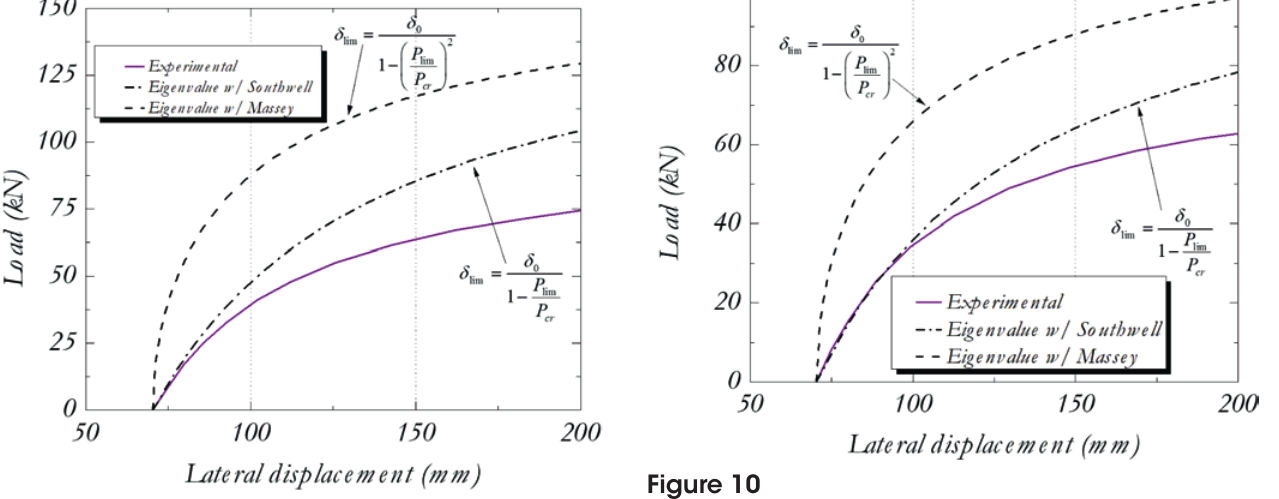
Load-lateral displacement response for 45 degrees skewed